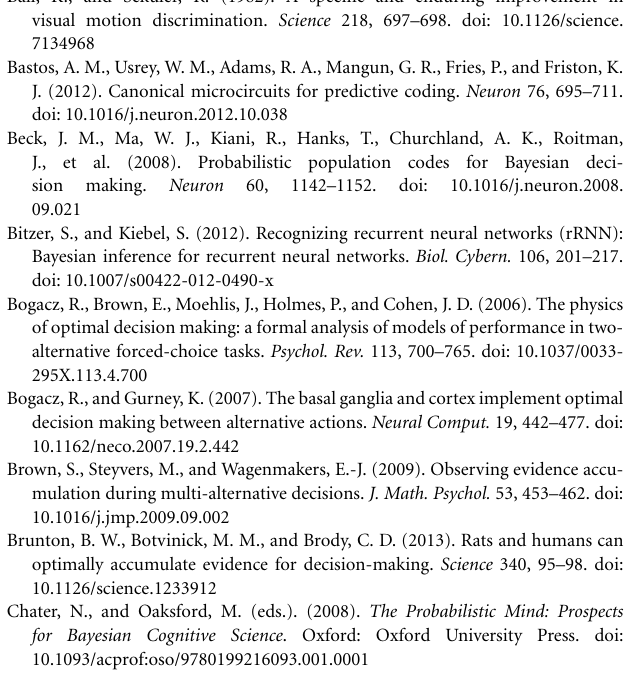
comparison we also plot the parameter values found by EZ (blue star) and DMAT (black star). The fitted data were obtained from the “low evidence,” SHAM condition of the second half of the experiment of Philiastides et al. (2011). This specific condition showed the largest differences between posteriors (using the two different Gaussian priors), i.e., for all other conditions, we found smaller and often vanishing